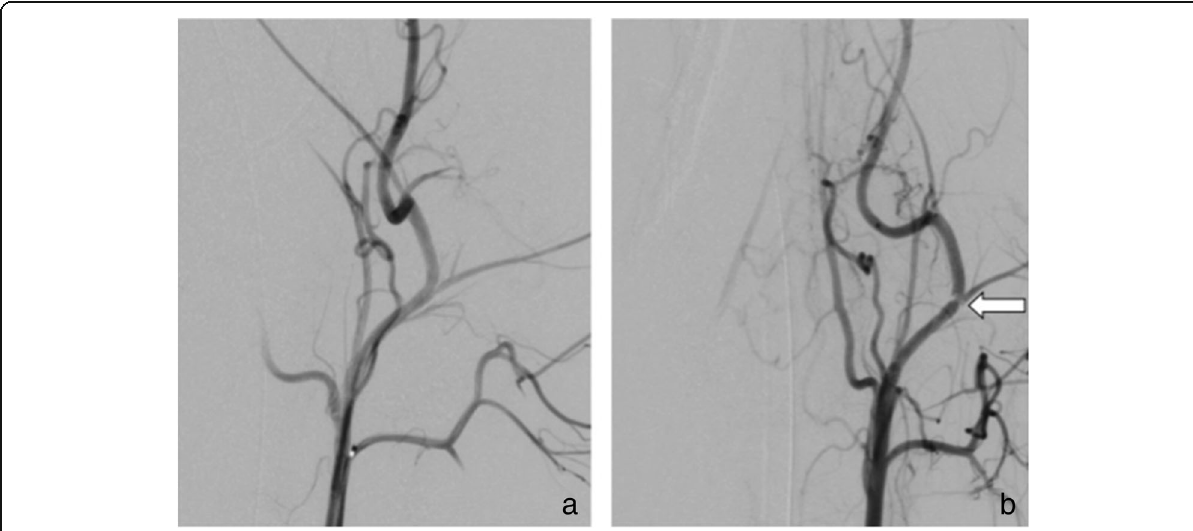
Fig. 2 Subtracted angiographic series of the left external carotid artery of subject number 3 (treated with ASA only), implanted with an HPC-1 coated p64 device. a The FDS immediately after implantation. b The FDS 22min after implantation, with a partial, acute in-stent thrombosis (white